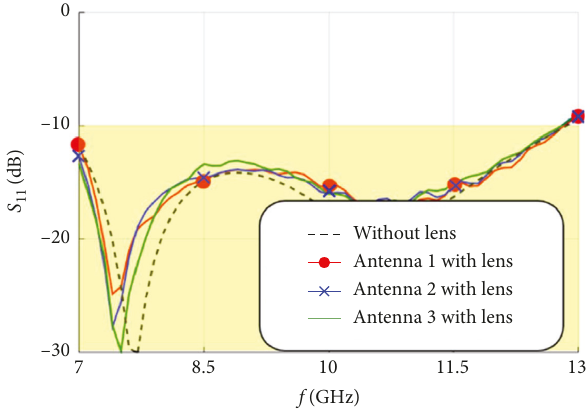
Figure 5: Influence of mutual coupling among feeders and re- flections that occur in the transition between air and lens in the reflection coefficient.